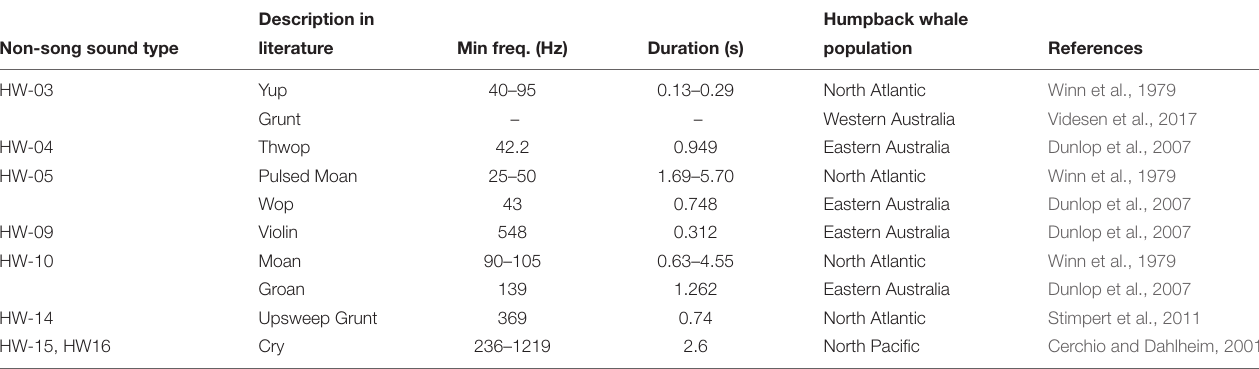
TABLE 5 | Summary of similarities in non-song sound types identified for humpback whales off Western Australia and those reported elsewhere based on spectral feature